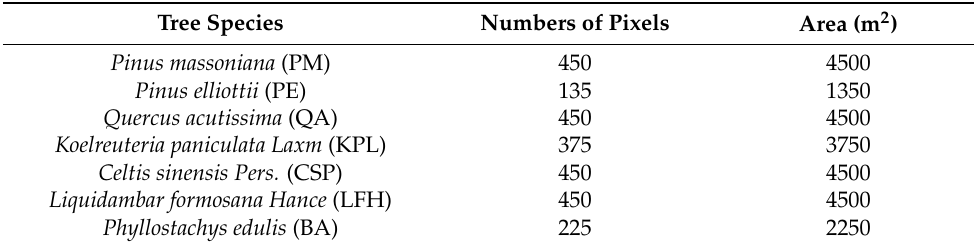
Table 1. The number of sample points and area. Tree Species Numbers of